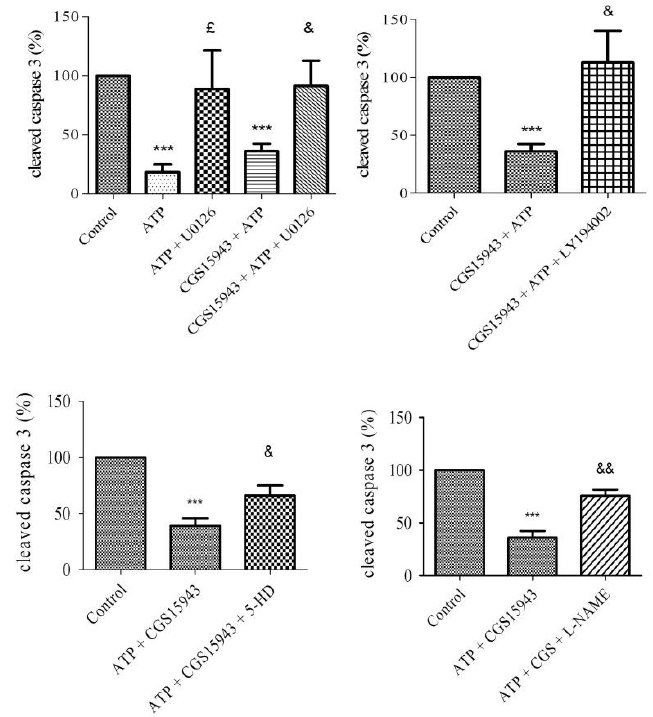
Figure 4. Signaling pathways involved in the P2-mediated anti-apoptotic effect of ATP. HUVECs were treated with different antagonists: 10 µ M U0126 (MEK/ERK1/2), 10 µ M LY294002 (PI3K), 100 µ M 5-HD (mitoK ATP ), and 10 µ M L-NAME (NOS). Then, cells were treated with 10 µ M ATP and 1 µ M CGS15943 and submit to 2 h of hypoxia. Data are means ± sem ( n = 6/group) of relative caspase 3 expression (%) in HUVECs after 2 h of hypoxia. £ p < 0.05, compared to 10 µ M ATP group. & p <